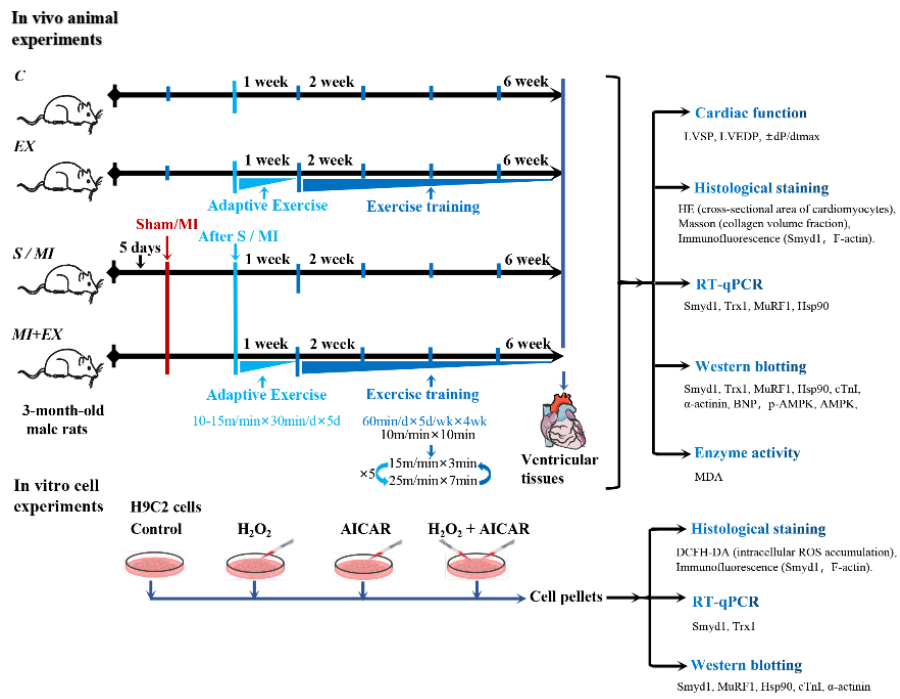
Figure 8. Illustrative descriptions of the experimental protocols, study methods, and investigated end-points: the in vivo experiments were performed in adult rats that underwent myocardial infarction (MI) with or without post-MI exercise training. The in vitro cellular experiments were conducted in cultured H9C2 rat cardiomyoblasts treated with or without H 2 O 2 or exercise memetic—AICAR (5-amino-1- β - d -ribofuranosyl-imidazole-4-carboxamide). Please refer the main text for the meanings of additional abbreviations.